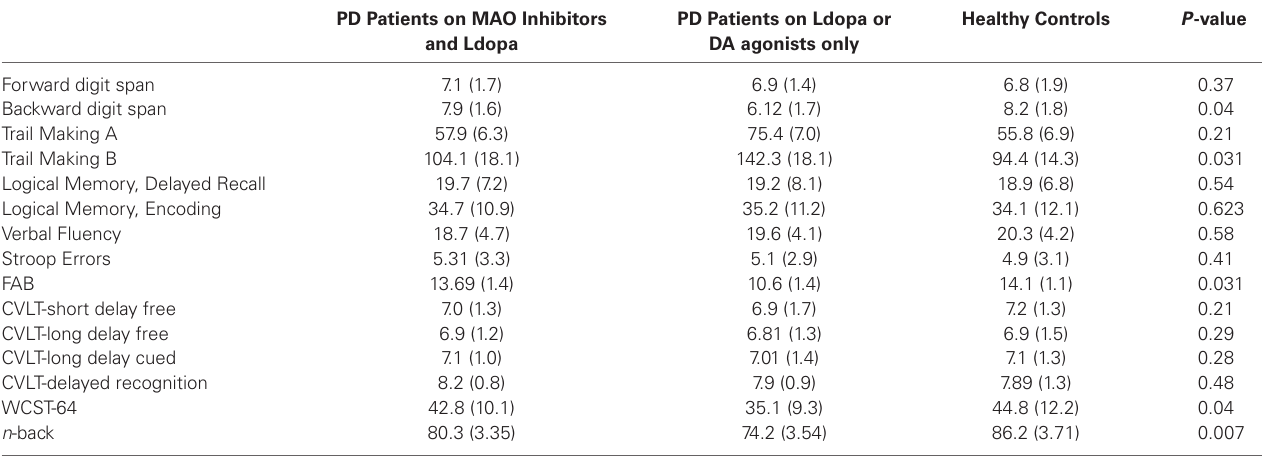
Table 2 | Effects of combined MAO-B Inhibitors vs. monotherapy on cognition